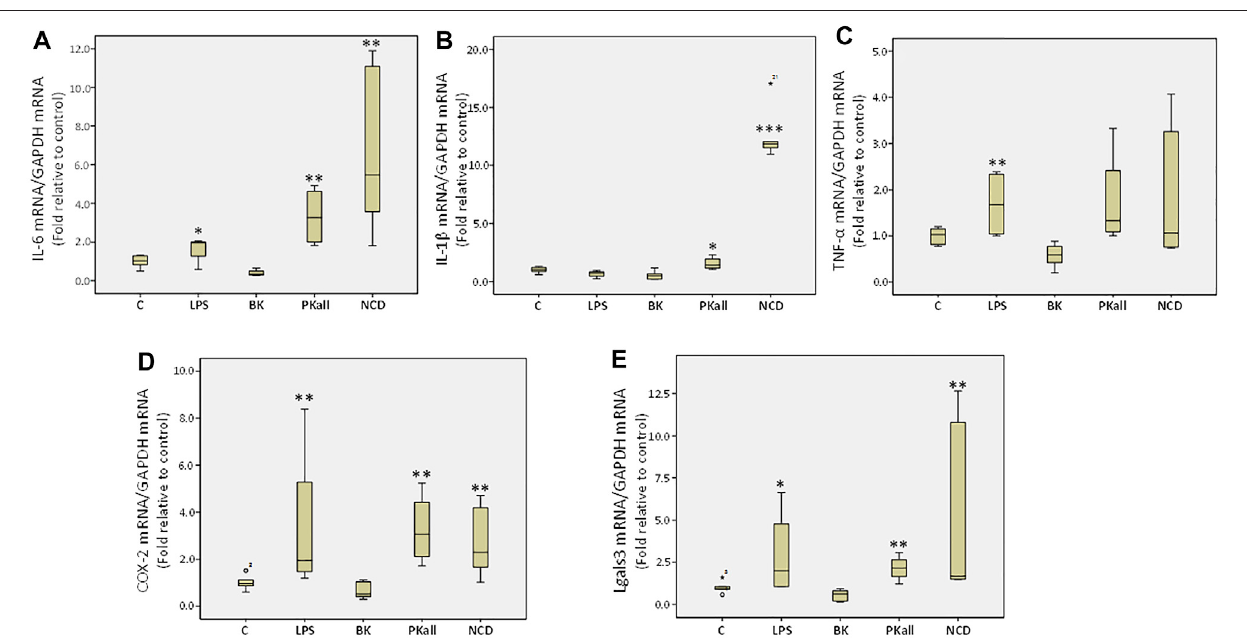
FIGURE3| Expressionofin fl ammatorymediatorsinmicroglialcells.Thegeneexpressionlevelsofin fl ammatorycytokinesmeasuredinN9microglialcellsexposed to LPS (100 ng/ml), BK (0.1 µM), PKall (2.5 ng/ml) and NCD (16.5 µg protein/ml) for 24 h. Boxplot graphs depicts the changes in mRNA levels of (A) interleukin-6 (IL-6), (B) interleukin-1 β (IL-1 β ), ( C) tumor necrosis factor-alpha (TNF- α ), (D) cyclooxygenase-2 (COX-2), and (E) galectin-3 (Lgals3) expressed relative to control mRNA levels and to GAPDH mRNA levels were determined in the same samples at the same experiment (* p ≤ 0.05,** p ≤ 0.01, *** p ≤ 0.004 vs. Control, n (cid:1)